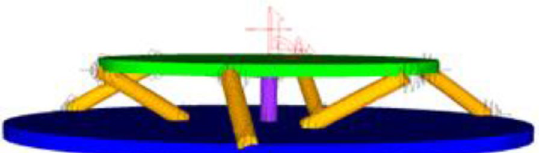
Figure 3 Simulation model of the 7-SS passive overconstrained structure